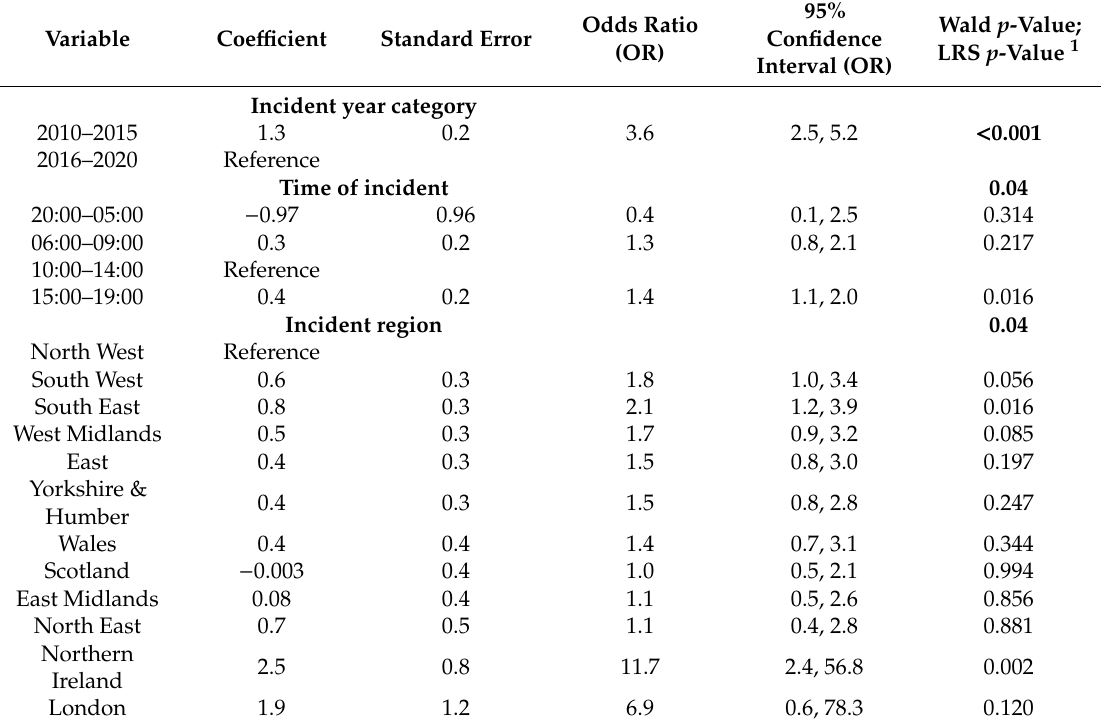
Table 2. Multivariable mixed-e ff ects logistic regression modelling, including reporter as a random e ff ect, of the incident- and rider / handler-related variables associated with higher odds of vehicle collisions in road incidents ( n = 3463) reported to the British Horse Society between 2010 and